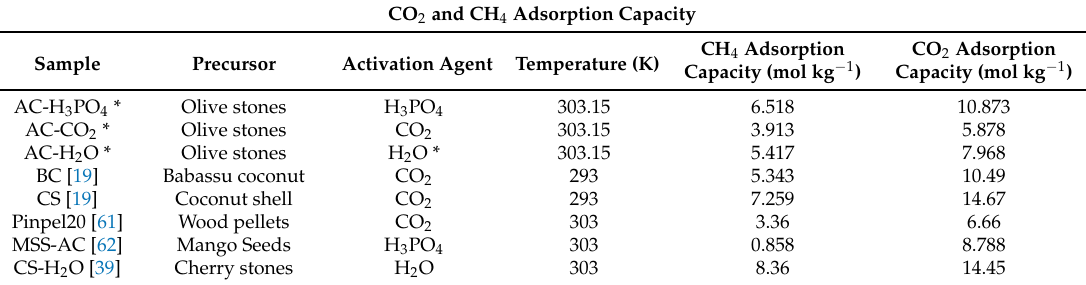
Figure 4. SSA normalized CO 2 adsorption isotherms of the activated carbons: AC-H 3 PO 4 (black circles), AC-CO 2 (red diamonds) and AC-H 2 O (turquoise triangles). Open symbols represent the adsorption data at 303.15 K, while the data at 323.15 are shown by the filled symbols 323.15 K. Table 5. Adsorption capacities of different biomass-based